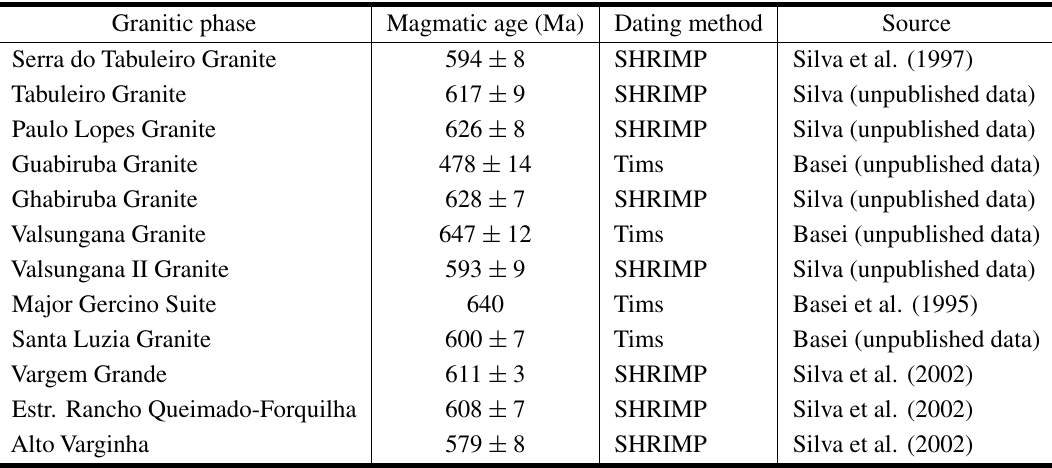
Previous geochronological data of the Florianópolis Batholith. All data are U-Pb zircon. All previously analyzed samples are from the area located to the north of Figure